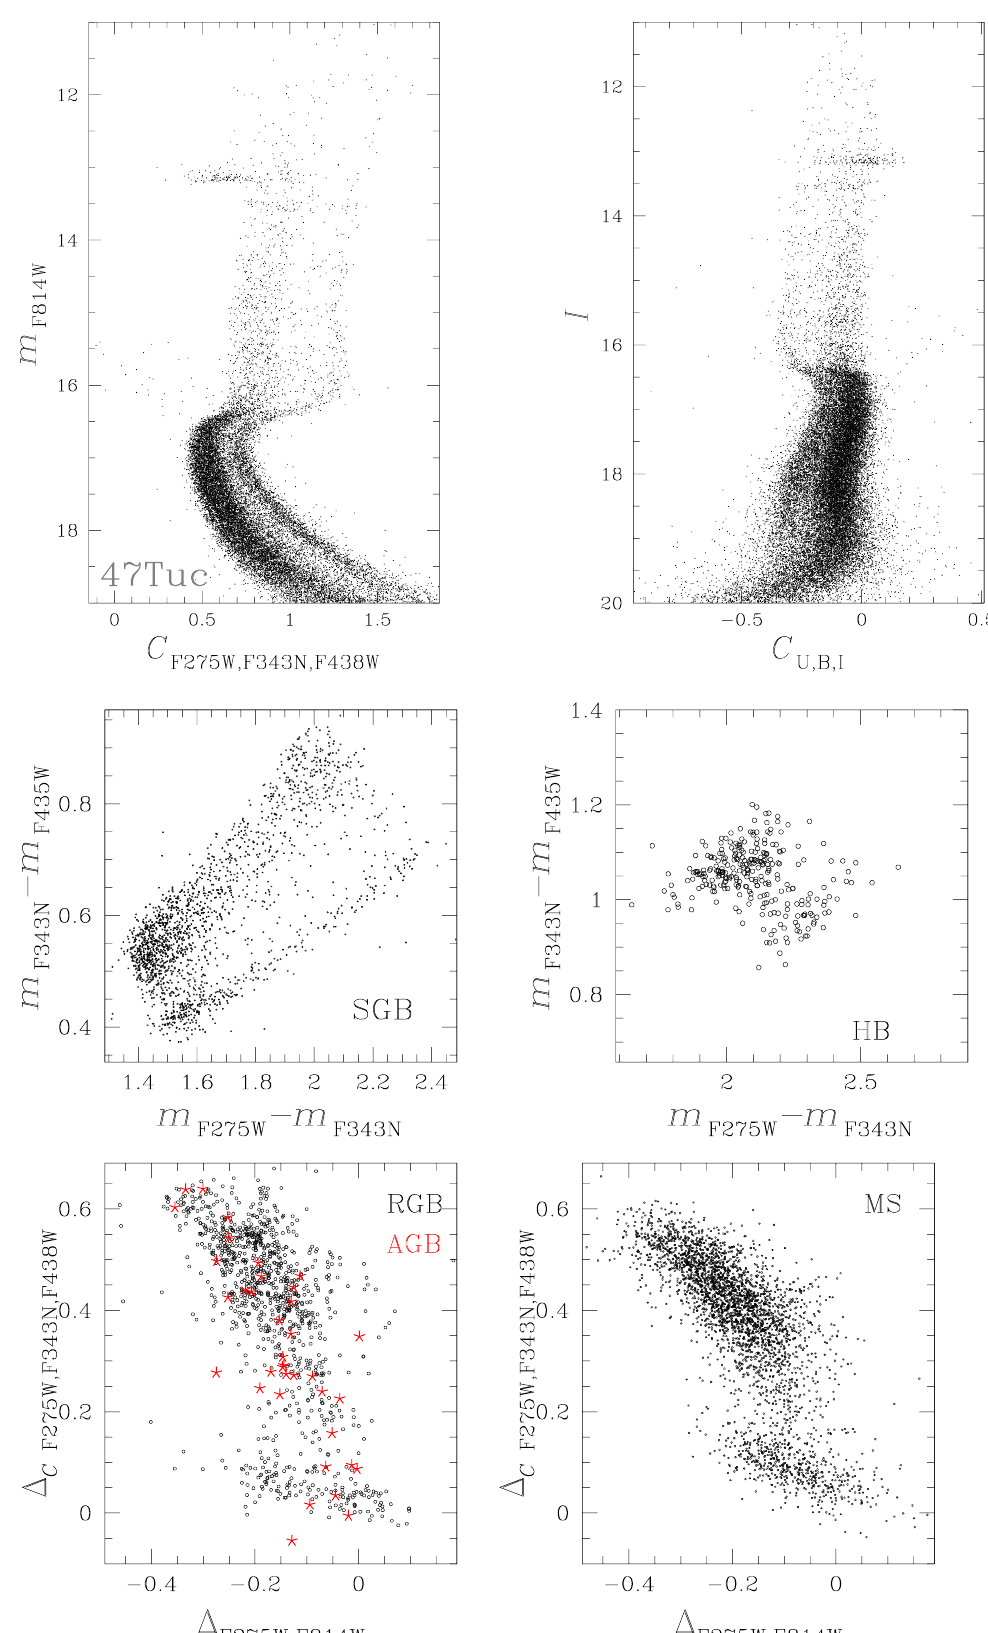
Figure 1. Collection of photometric diagrams to identify multiple populations in 47Tucanae. The figures are derived from the photometric catalogs by Milone et al.